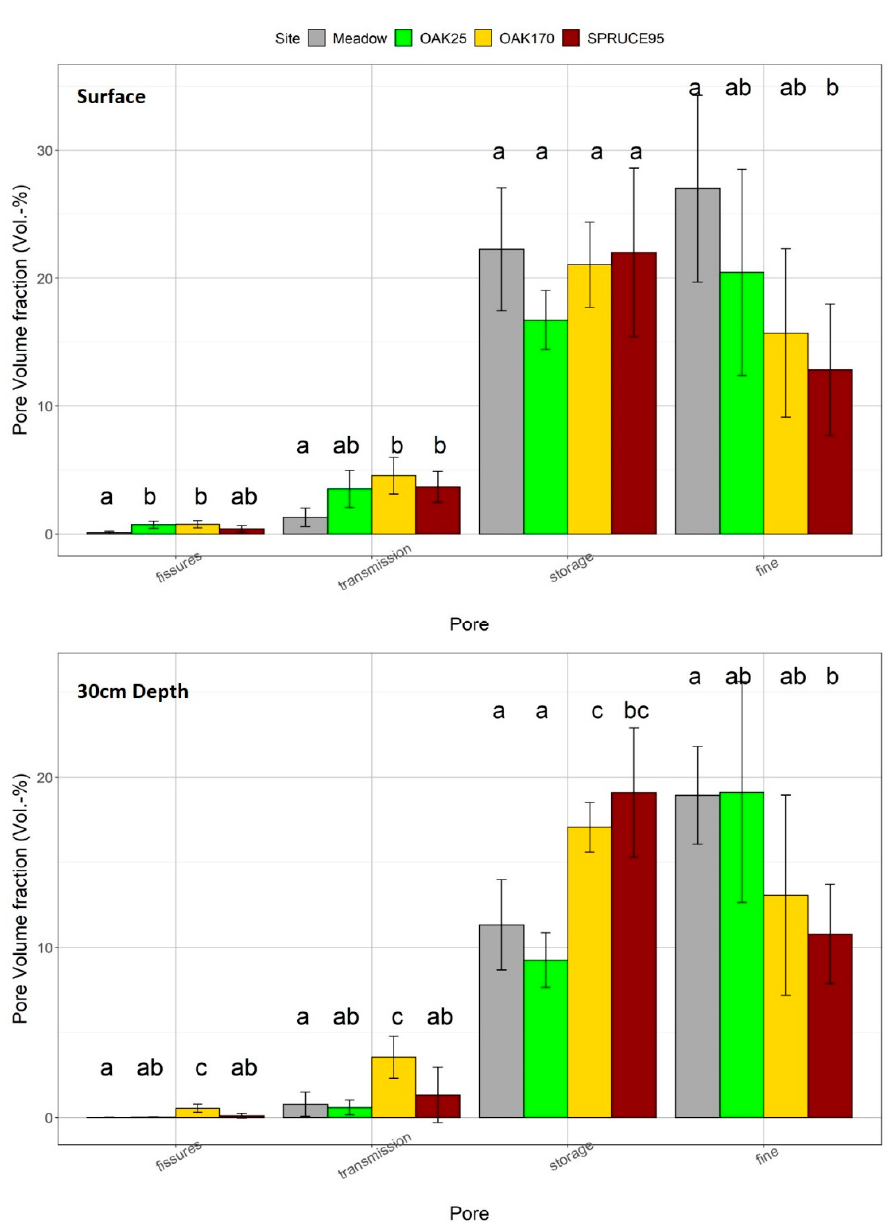
Figure 4. Volume fraction of different pore size classes for the samples from the surface (upper plot) and samples from 30 cm depth (lower plot) obtained from the area under bimodal pore size distribution Classes were fissures (diameter ∅ > 500 µ m), transmission ( ∅ 50–500 µ m), storage ( ∅ 1.5–50 µ m), and fine pores ( ∅ < 1.5 µ m). Fissures, transmission, and storage pores are derived from the measured part of the water retention curve, and the fine pores are determined from the extrapolated part of the water retention curve. Same lowercase letters over the bars are not significantly different at p < 0.05 among the pore size